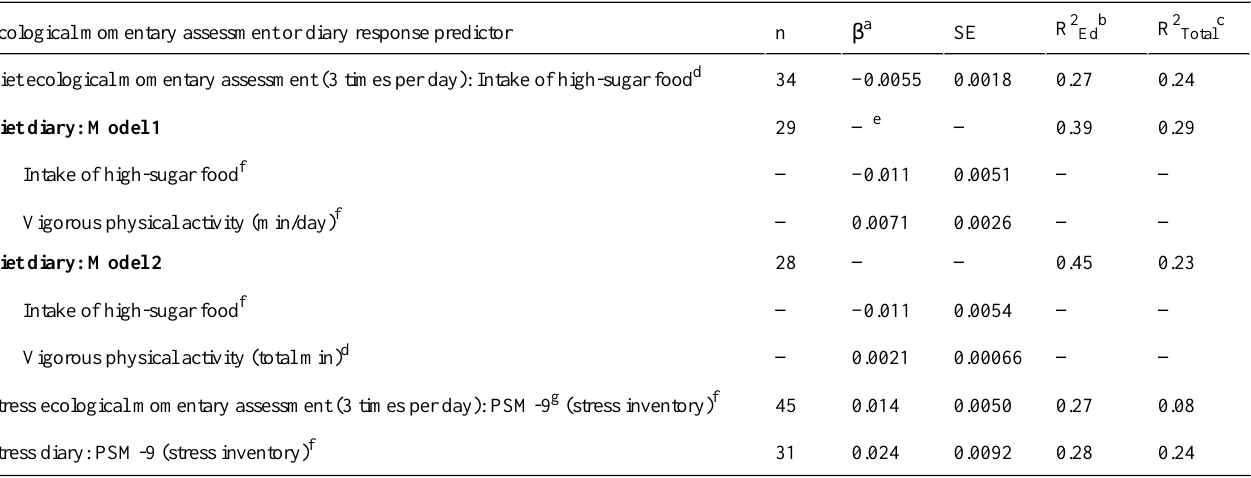
Table 6. Final random effects linear regression models showing the associations between ecological momentary assessment and diary and recall-based predictor